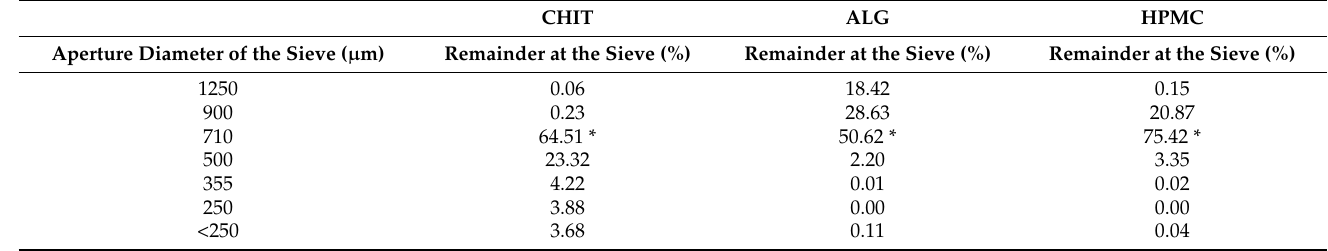
Table 3. Particle size distribution estimation of the pellets containing chitosan (CHIT), sodium alginate (ALG), or hydroxypropyl methylcellulose (HPMC) as a binder. CHIT ALG HPMC